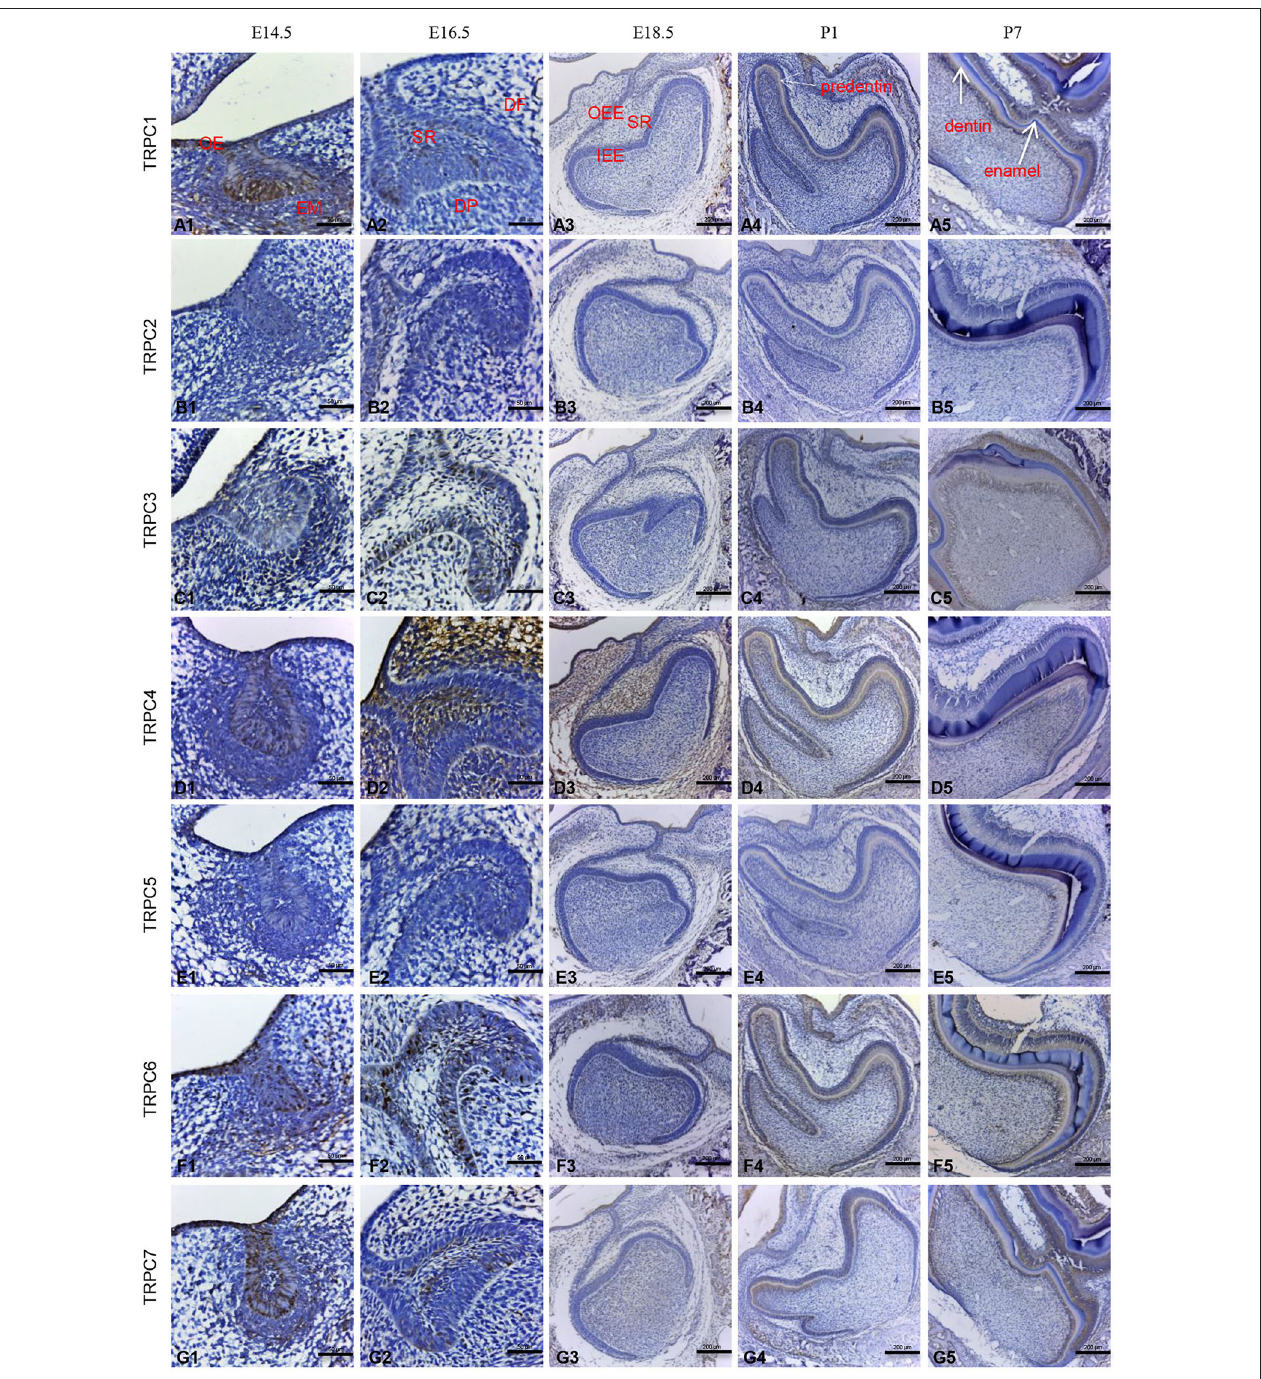
FIGURE 4 | IHC staining of TRPC channels at different rat tooth germdevelopmental stages (E14.5–P7). The TRPC expression was temporally and spatially stage-specific during the tooth germ development. At E14.5, the expression of TRPC1, TRPC3, TRPC6, TRPC7 were mainly observed in epithelial cells (A1, C1, F1, G1) . At E16.5, the expression of TRPC1, TRPC3, TRPC6, TRPC7 were observed in outer enamel epithelial cells and inner enamel epithelial cells (A2, C2, F2, G2) . The expression of TRPC4 was observed in stellate reticulum cells and dental follicle cells (D2) . At E18.5, weak expression of TRPC3, TRPC6, TRPC7 were found in inner and outer enamel epithelial cells (C3, F3, G3) . The expression of TRPC4 was observed in stellate reticulum cells and dental follicle cells (D3) . At P1, the expression of TRPC1, TRPC3, TRPC4, TRPC6, and TRPC7 were detected in preameloblasts and odontoblasts (A4, C4, D4, F4, G4) . At P7, the expression of TRPC1, TRPC3, TRPC6, and TRPC7 were detected in ameloblasts and odontoblasts (A5, C5, F5, G5) . TRPC2 and TRPC5 were not detected during the development (B1–B5, E1–E5) . Scale bars: 200 µ m (A3–A5) . Scale bars: 50 µ m (A1, A2) . OE, oral epithelium; EM, ectoblastic mesenchyme; DF, dental follicle; DP, dental papilla; SR, stellate reticulum; IEE, inner enamel epithelium; OEE, outer enamel epithelium.